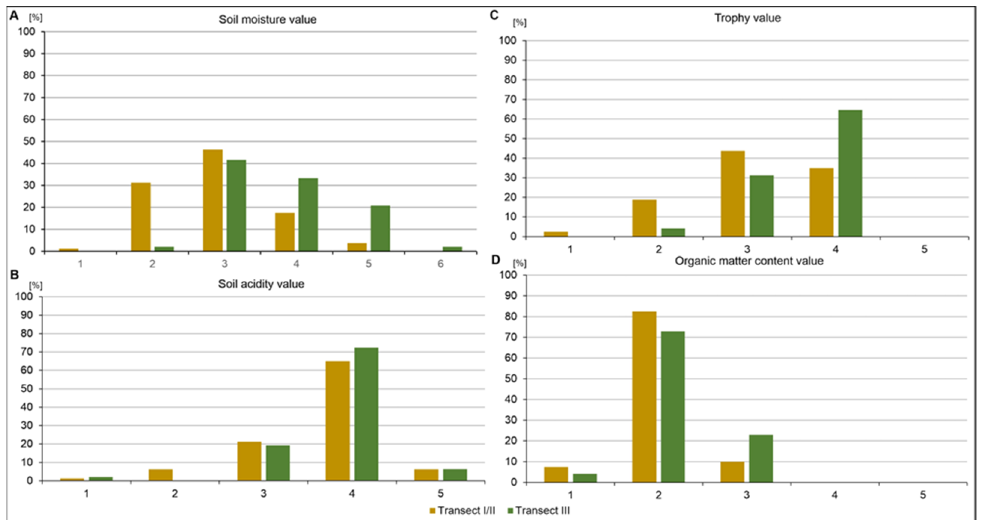
Figure 8. The differentiation of species according to soil moisture ( A ), soil reaction ( B ), trophy ( C )